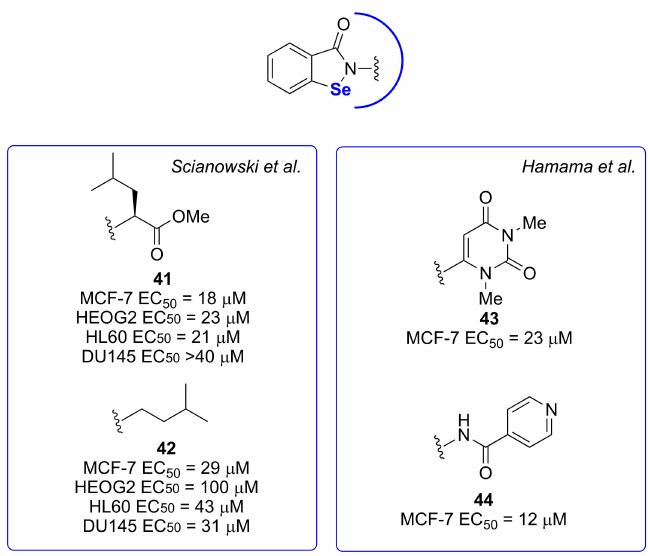
Figure 11. Compounds endowed with antiproliferative